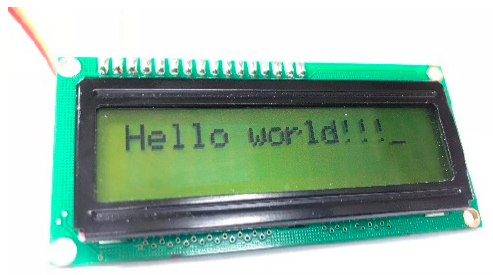
corresponding text.